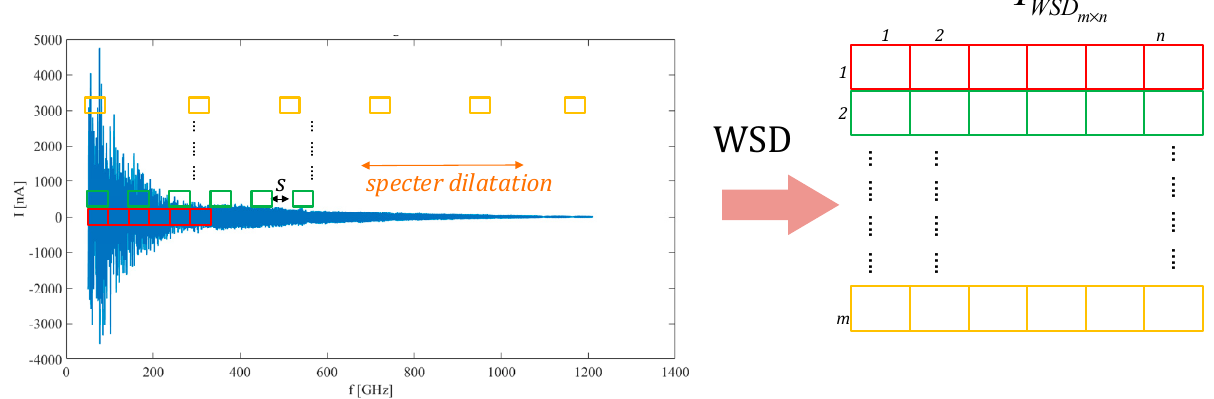
Figure 8. The windowing spectrum dilation (WSD) transformation technique. The WSD transformation can be used on different data sets and preprocessing stages. Regarding the downsampling algorithm and WSD, the approach is practical for lowering image resolution while still preserving data characteristics. From the WSD adjacent im- age row’s observation, each further row contains the data set, which is extended in the measured spectrum, but downsampled regarding the data set. In other words, each new layer of WSD image represented the low-pass values of the data. This means that the adequately downsampled data preserves mainly the shape of the envelope in all image layers. The aforementioned confirms that the WSD image transformation is, consequently, more resilient to the uncertainties. The image does not contain sharp edges at the first rows of the image, as can be noticed in the SetCT method. Sharp edges are mainly a consequence of the image assembly with a fixed length, where the extracted envelope is decreasing monotonically. The preprocessing algorithm contains PFF, envelope extraction, the downsampling algorithm, and WSD transformation. The sequence of the preprocessing algorithms is presented in Figure 9.